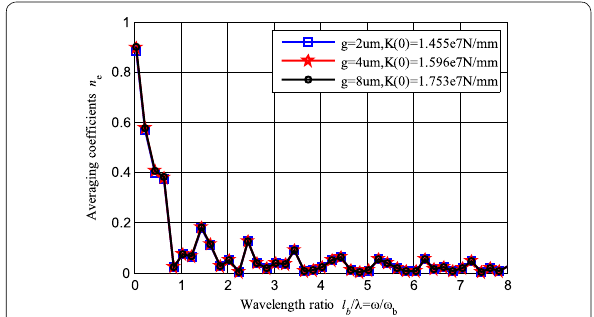
Figure 14 Averaging coefficient curves for different roller preloads